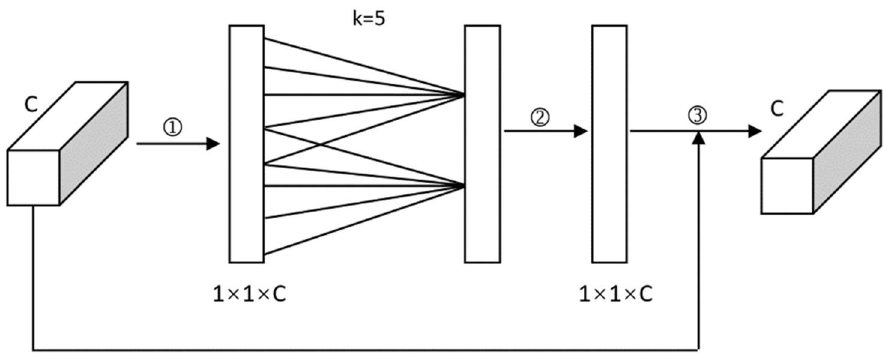
Figure 4. The network of ECA ( ○ 1 : given the aggregated features obtained by global average pooling (GAP); ○ 2 : 𝜎 ; ○ 3 : ×).